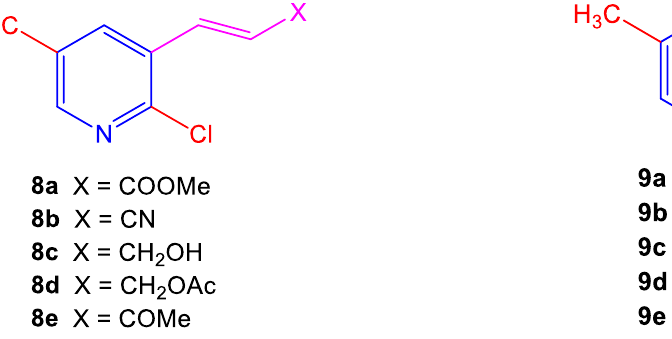
Figure 6. Structures of compounds ( 8a – e and 9a – e ) showing anti-microbial activity.